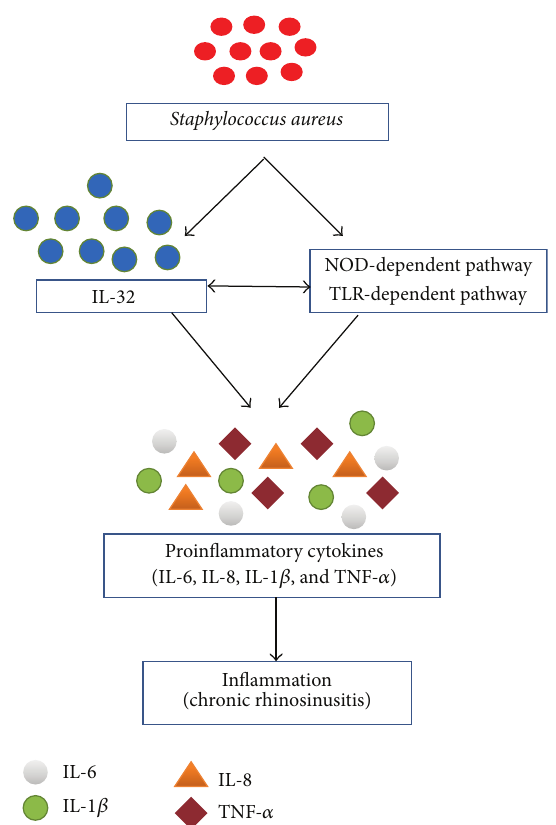
Figure 4: Involvement of Staphylococcus aureus in IL-32 induced inflammation in chronic rhinosinusitis. Staphylococcus aureus induces the expression of IL-32 as well as initiating the NOD- dependent pathway and TLR-dependent pathway which synergis- tically stimulate the production of some potent proinflammatory cytokines that results in inflammation of chronic